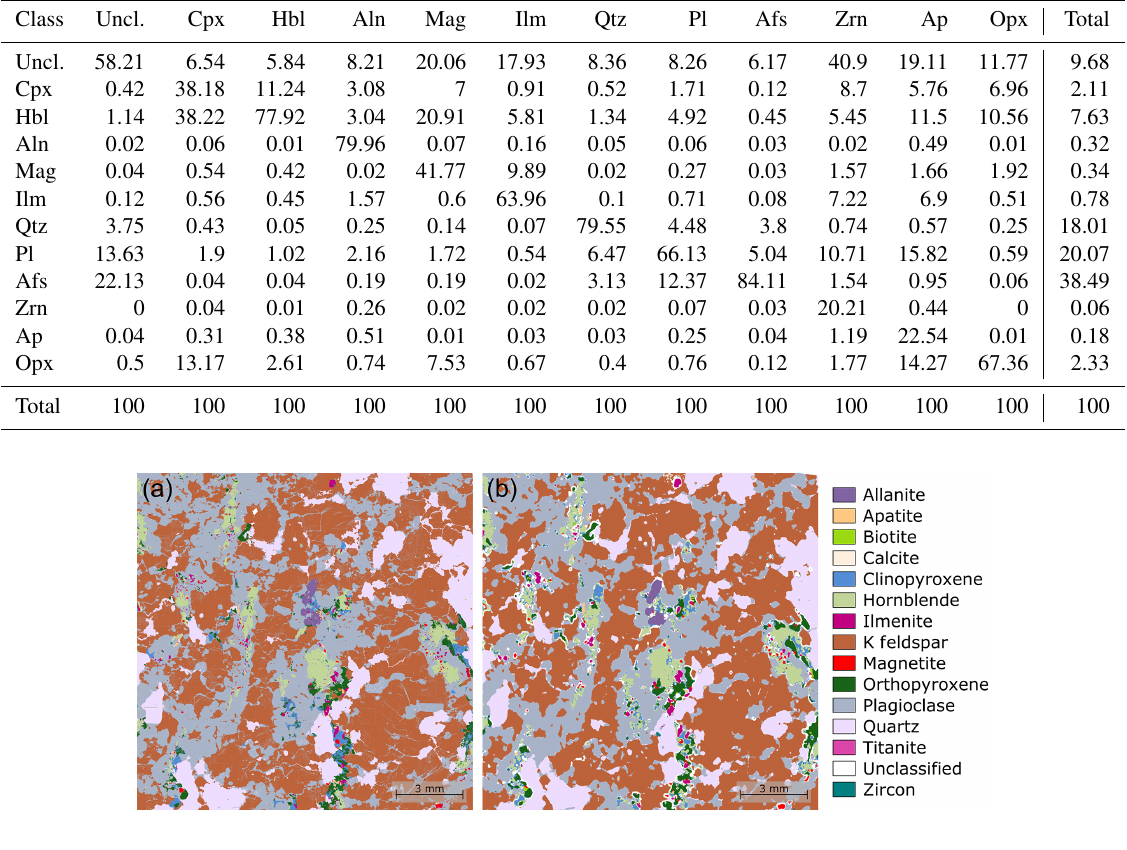
nesium or manganese would indicate the iron carbonate, but several possibilities still remain for